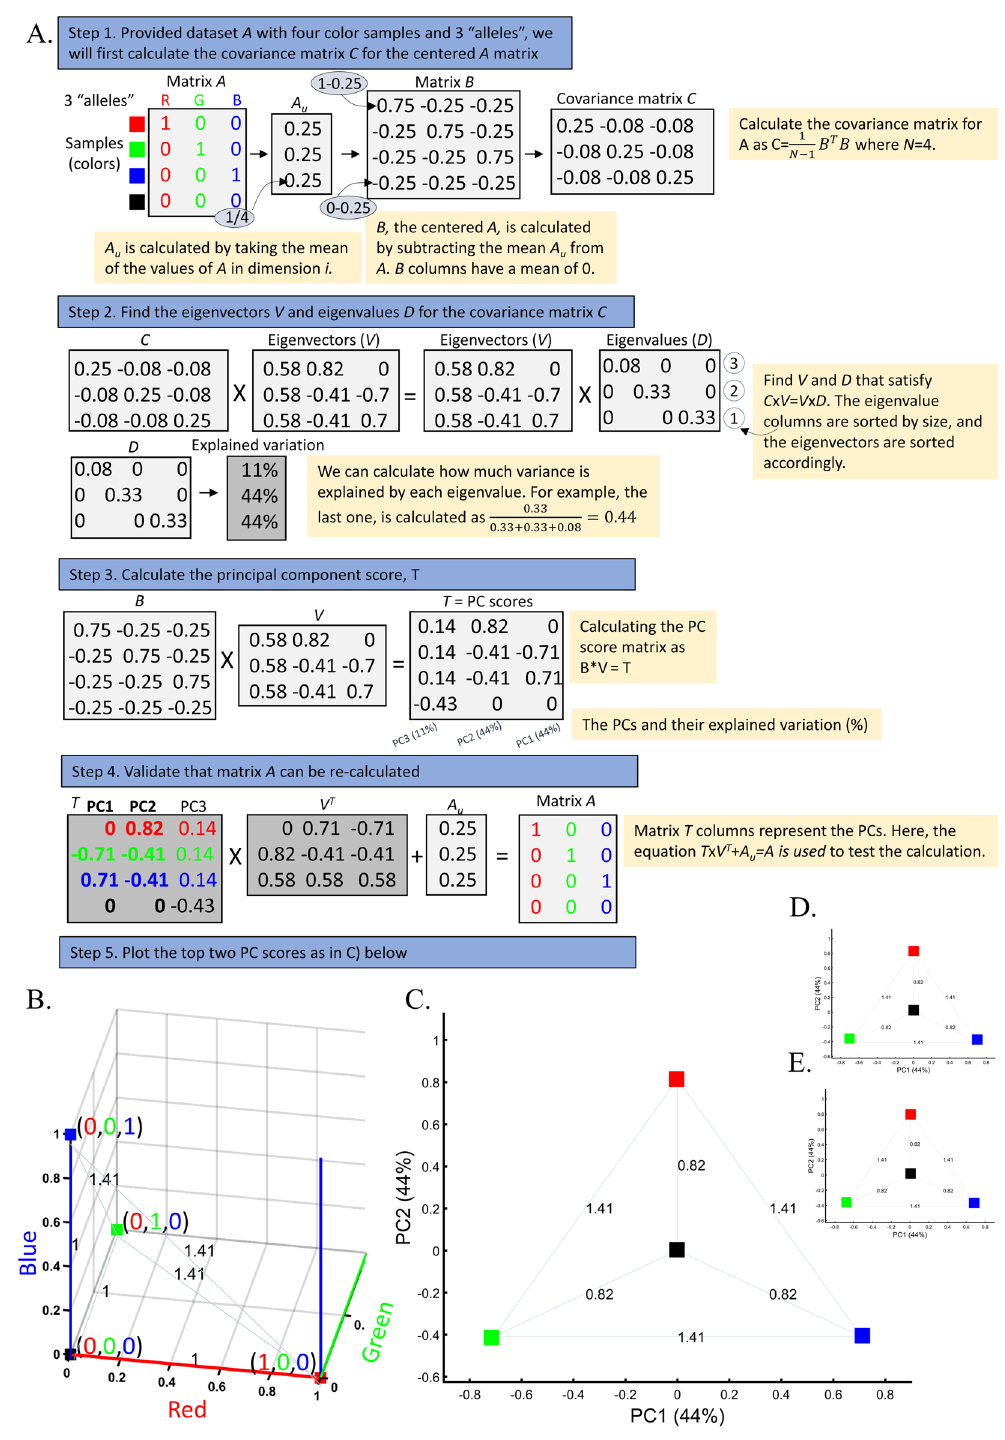
Figure 1. Applying PCA to four color populations. ( A ) An illustration of the PCA procedure (using the singular value decomposition (SVD) approach) applied to a color dataset consisting of four colors ( n All = 1). ( B ) A 3D plot of the original color dataset with the axes representing the primary colors, each color is represented by three numbers (“SNPs”). After PCA is applied to this dataset, the projections of color samples or populations (in their original color) are plotted along their first two eigenvectors (or principal components [PCs]) with ( C ) n All = 1, ( D ) n All = 100, and ( E ) n All = 10,000. The latter two results are identical to those of ( C ). Grey lines and labels mark the Euclidean distances between the color populations calculated across all three